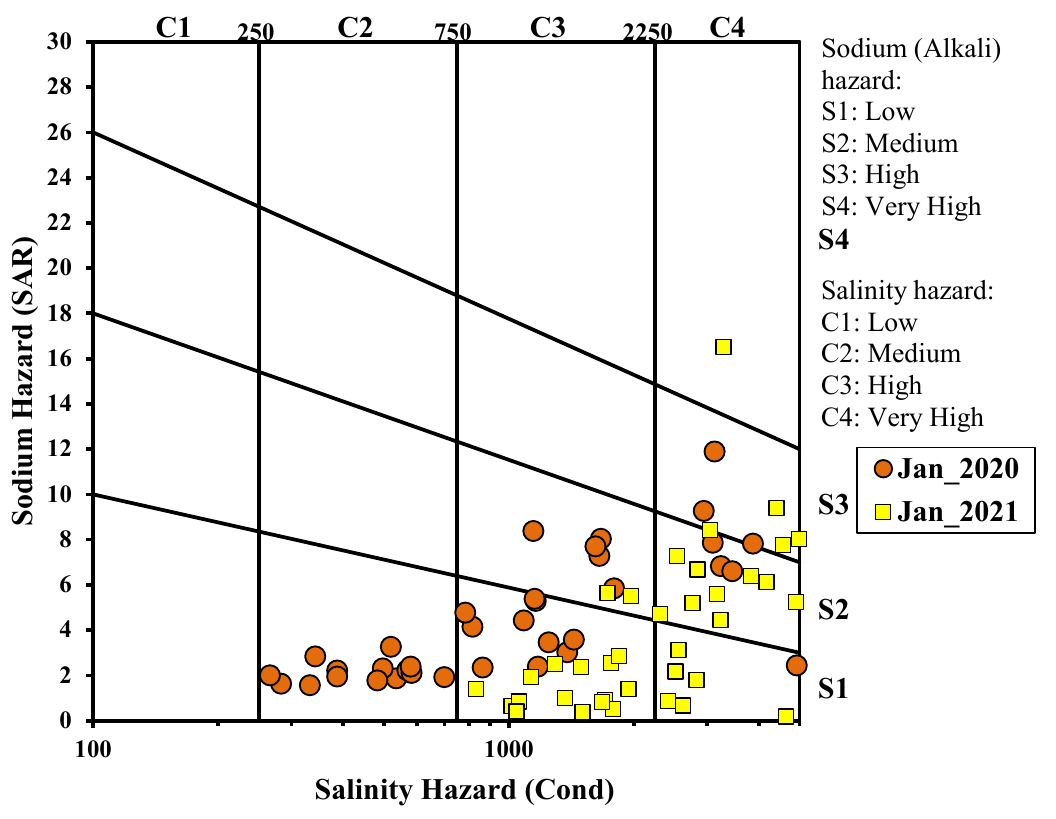
Figure 5. USSL plot for irrigation water quality.